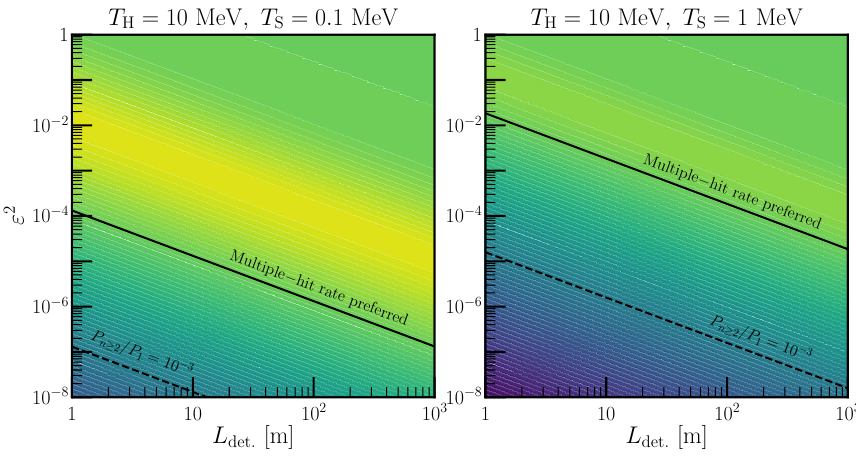
Figure 8 . Multiple-hit vs. single-hit search ratios. Ratio of multiple soft-scatter events to single hard-scatter events as a function of total detector length L det . and ε 2 for two choices of T H and T S , as labelled. Above the solid black lines, the double-hit rate exceeds the single-hit one. Above the dashed lines, the double-hit rate is at most three orders of magnitude smaller than the single-hit